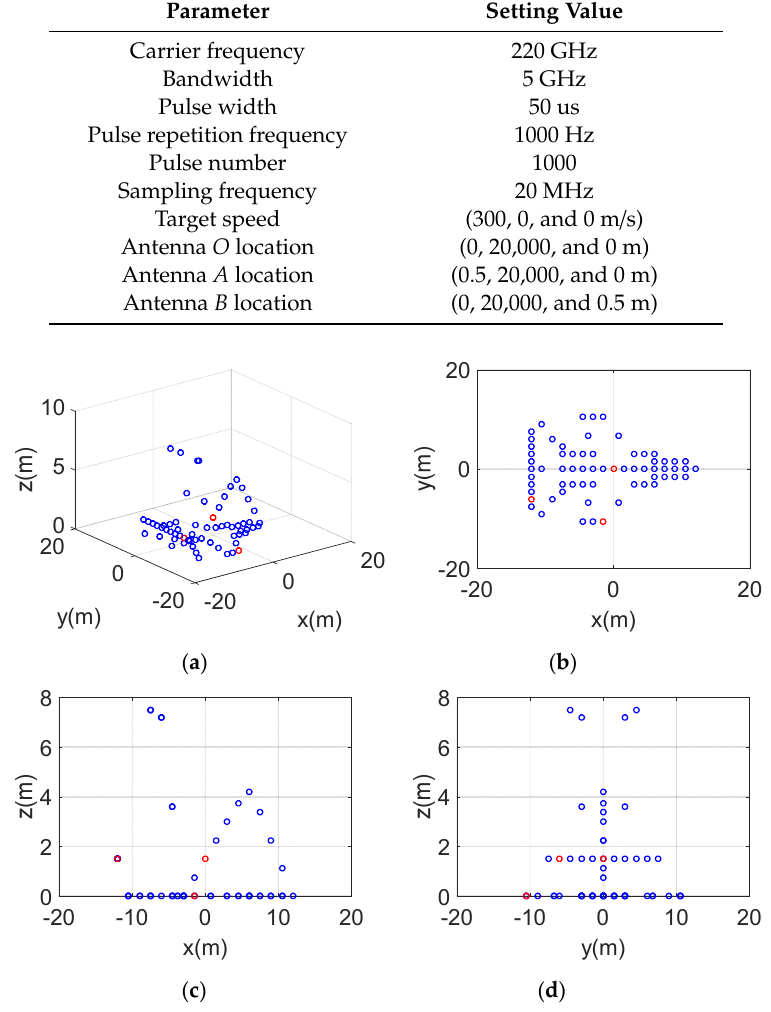
Figure 3. Four different views of the airplane model. ( a ) 3-D view; ( b ) xoy view projection; ( c ) xoz view projection; and ( d ) yoz view projection.